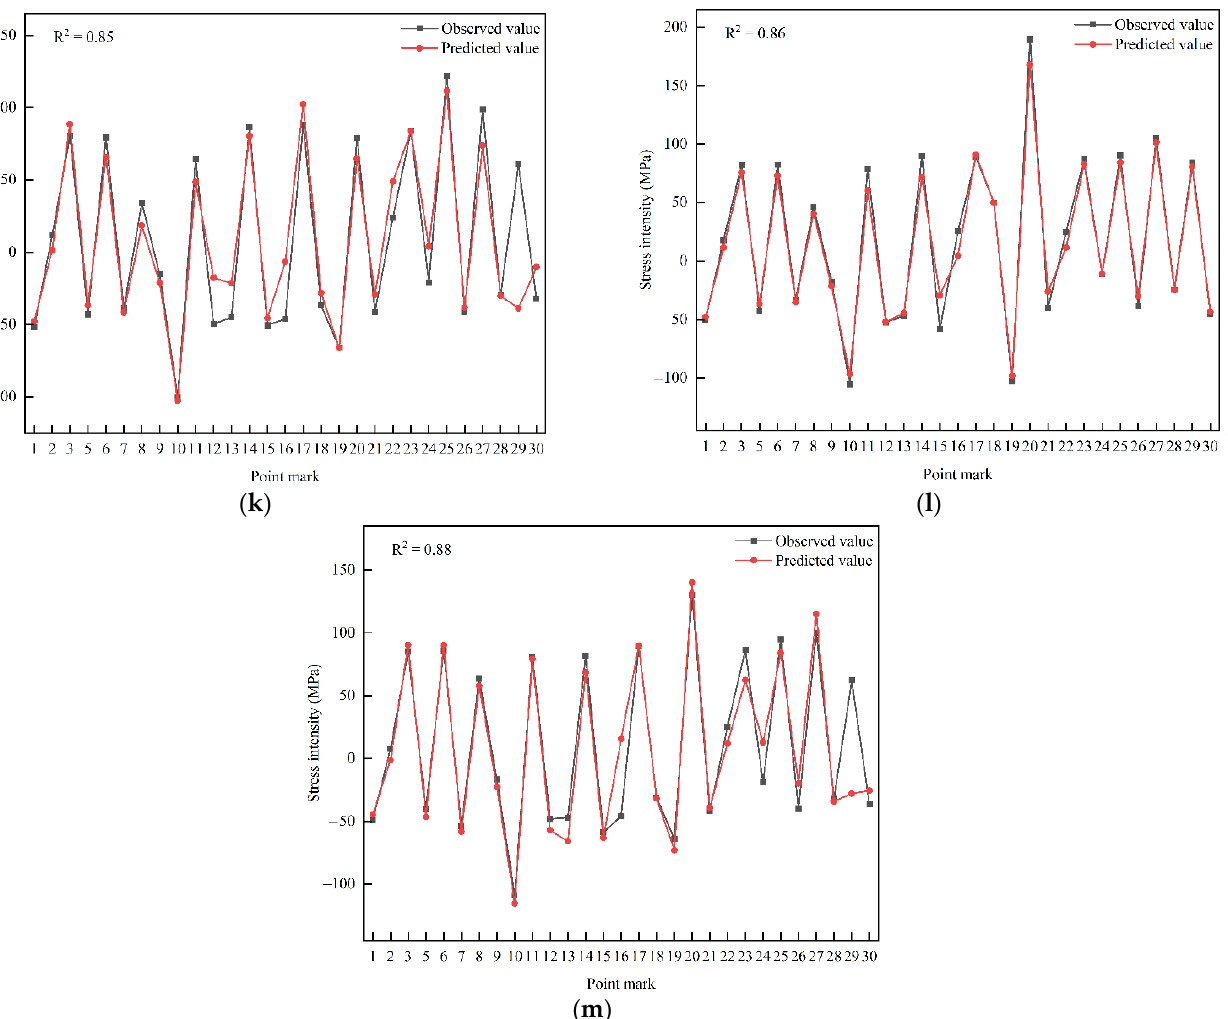
Figure 10. Correlative prediction output diagram of mechanical properties of multiple stages and multiple measuring points for valve hall hoisting. ( a ) Time series 1; ( b ) time series 2; ( c ) time series 3; ( d ) time series 4; ( e ) time series 5; ( f ) time series 6; ( g ) time series 7; ( h ) time series 8; ( i ) time series 9; ( j ) time series 10; ( k ) time series 11; ( l ) time series 12; ( m ) time series 13.